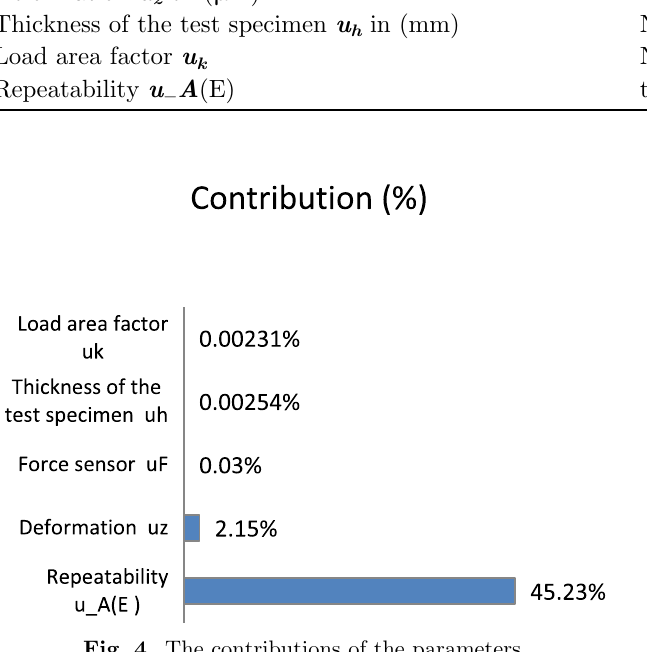
Fig. 4. The contributions of the parameters.